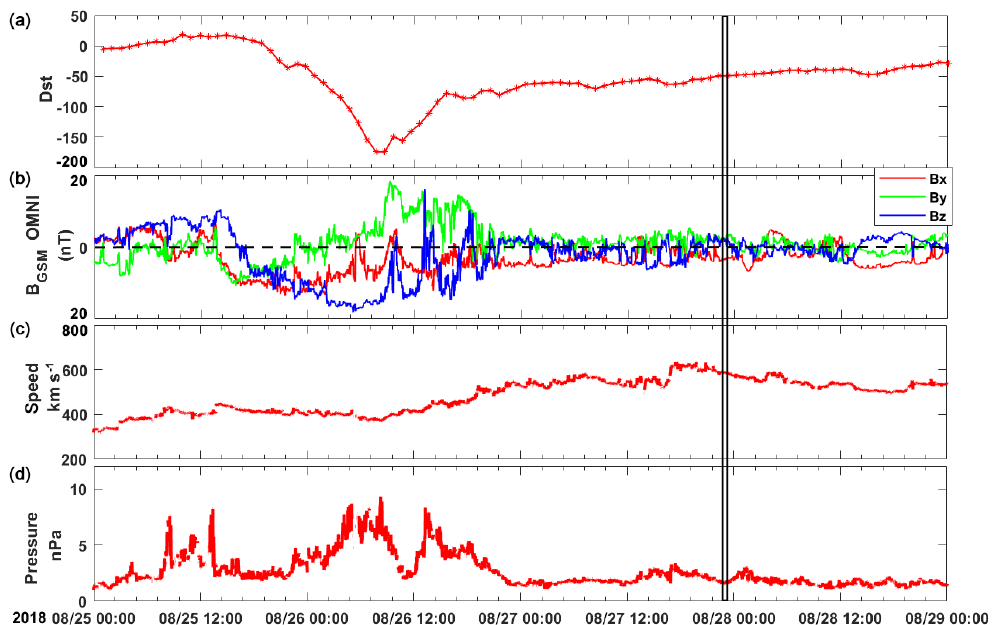
Figure 1. The solar wind conditions and geomagnetic index from 25 to 29 August 2018. From top to bottom: Dst index (a) , interplanetary magnetic field (b) , solar wind speed (c) , and solar wind dynamic pressure (d) , respectively. CSES observation of Pc1 waves is indicated by the black